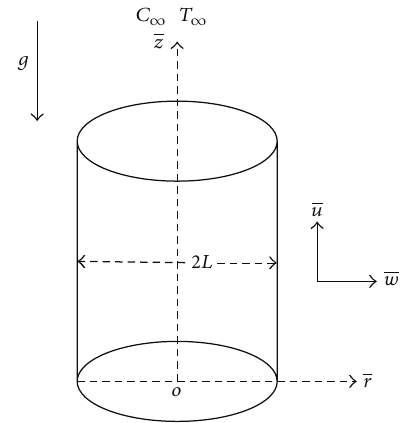
Figure 1: Physical model and coordinate